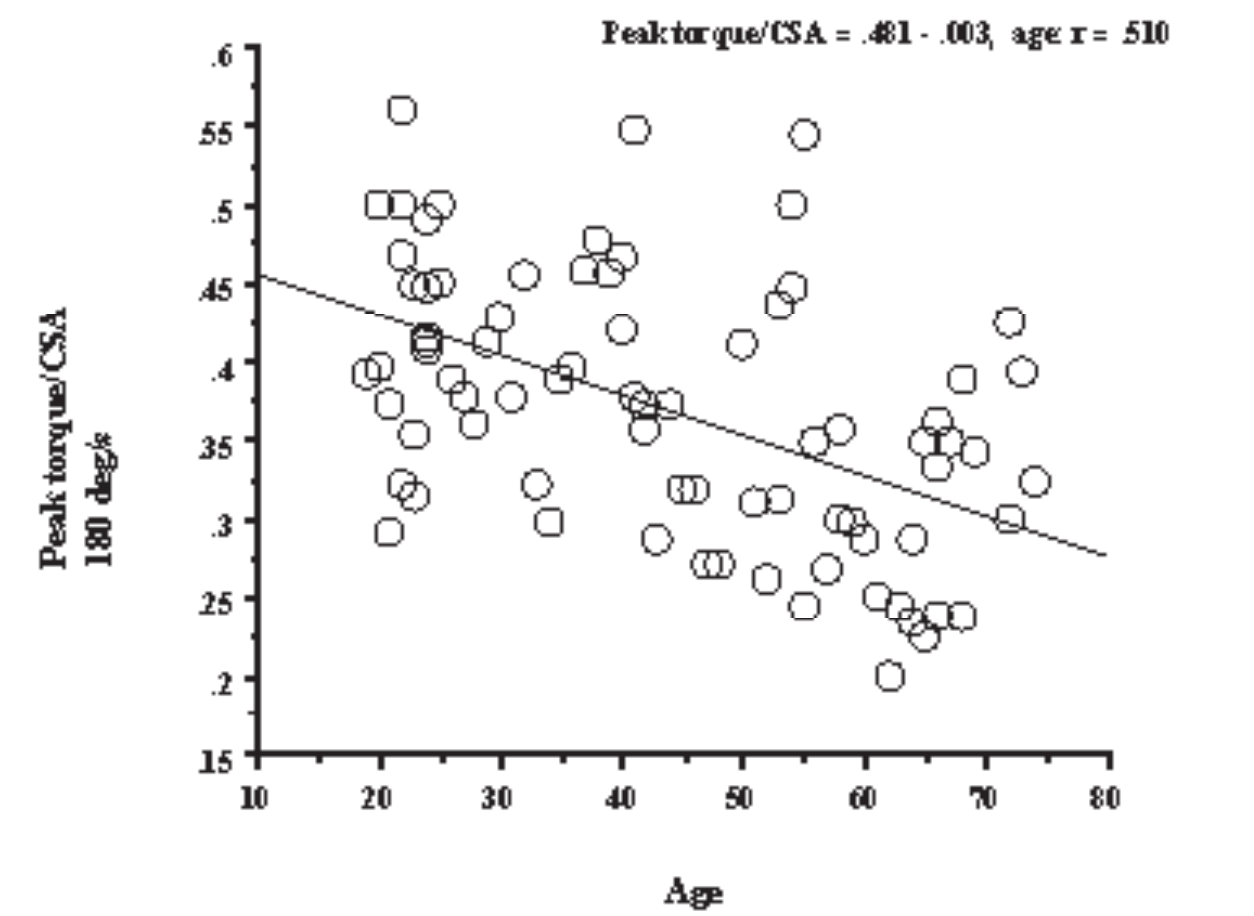
Fig. 5(B): The peak torque / CSA ratio and aging were less significantly correlated in both the angular velocities. (B: 180 deg/s angular velocity, r = 0.510, p